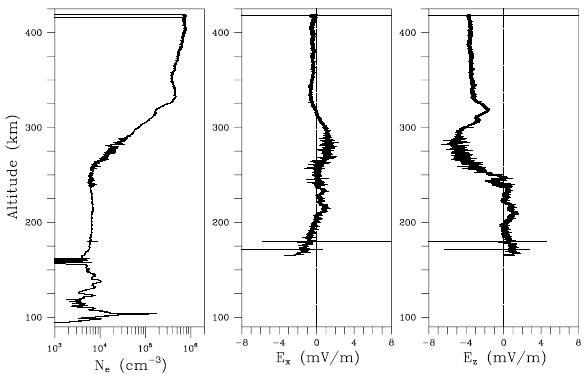
Fig. 13. Upleg data from the 15 August rocket flight. Left panel: electron density. Center panel: zonal electric field. Right panel: vertical electric field.